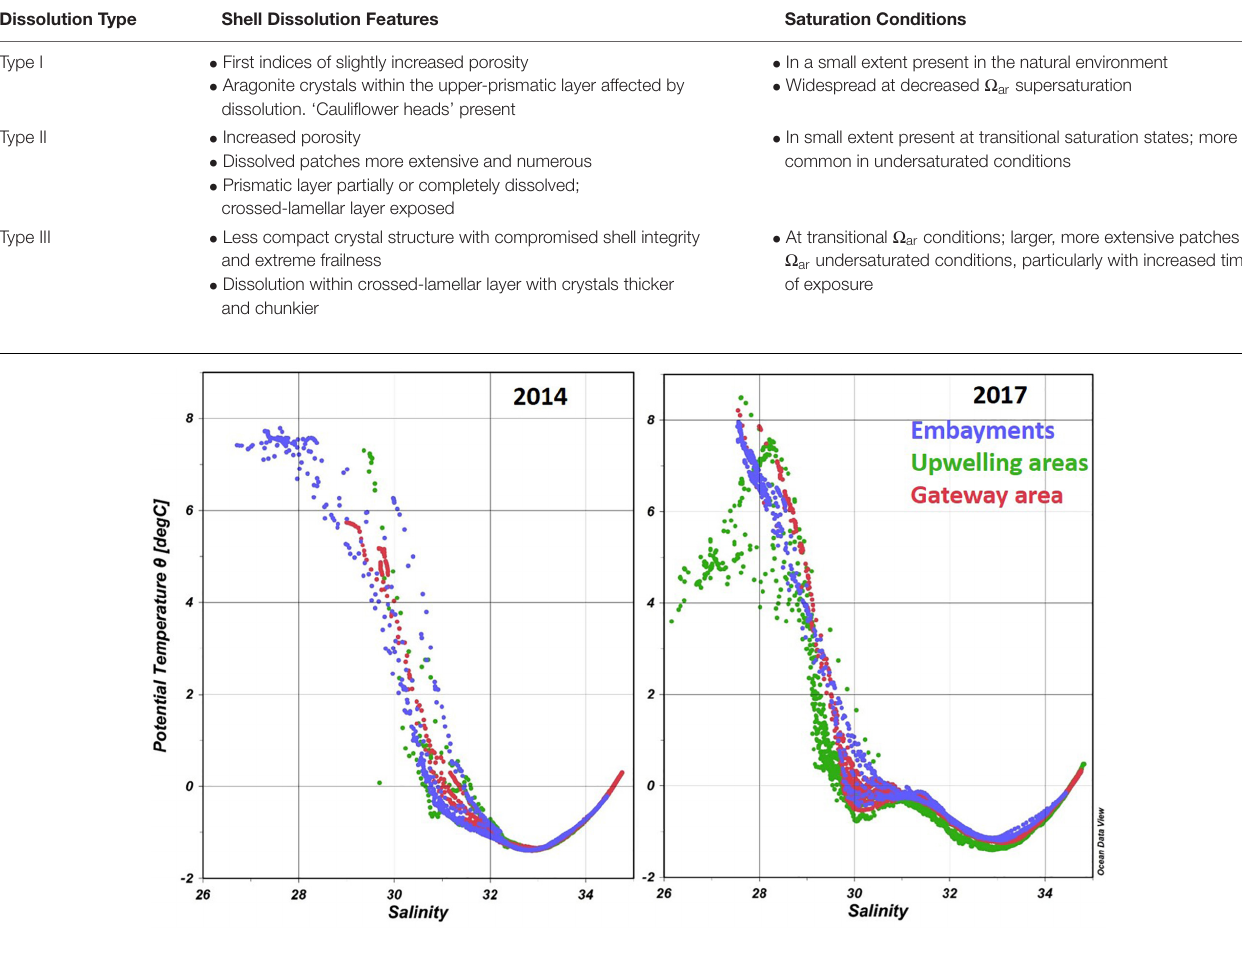
FIGURE 2 | Temperature-salinity plots for pteropod shell dissolution focal areas in the Amundsen Gulf in 2014 and 2017. Embayments include Wise and Walker bays, and Minto Inlet in 2014 and Minto Inlet in